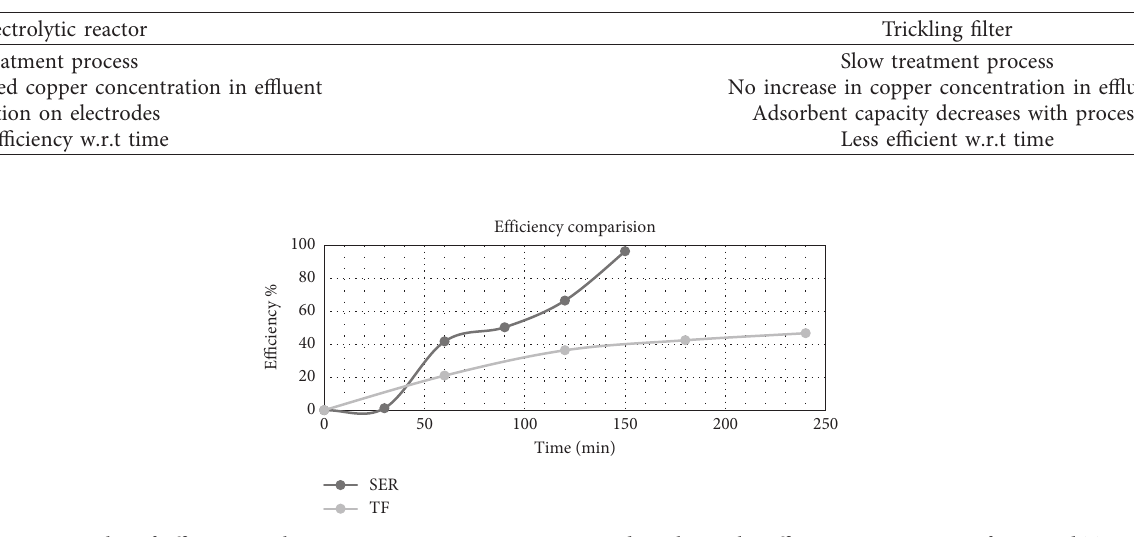
Figure 11: Plot of absorbance with respect to wavelength over 830nm. It shows the treatment efficiency of trickling filter. Table 7: Comparative analysis of treatment systems.